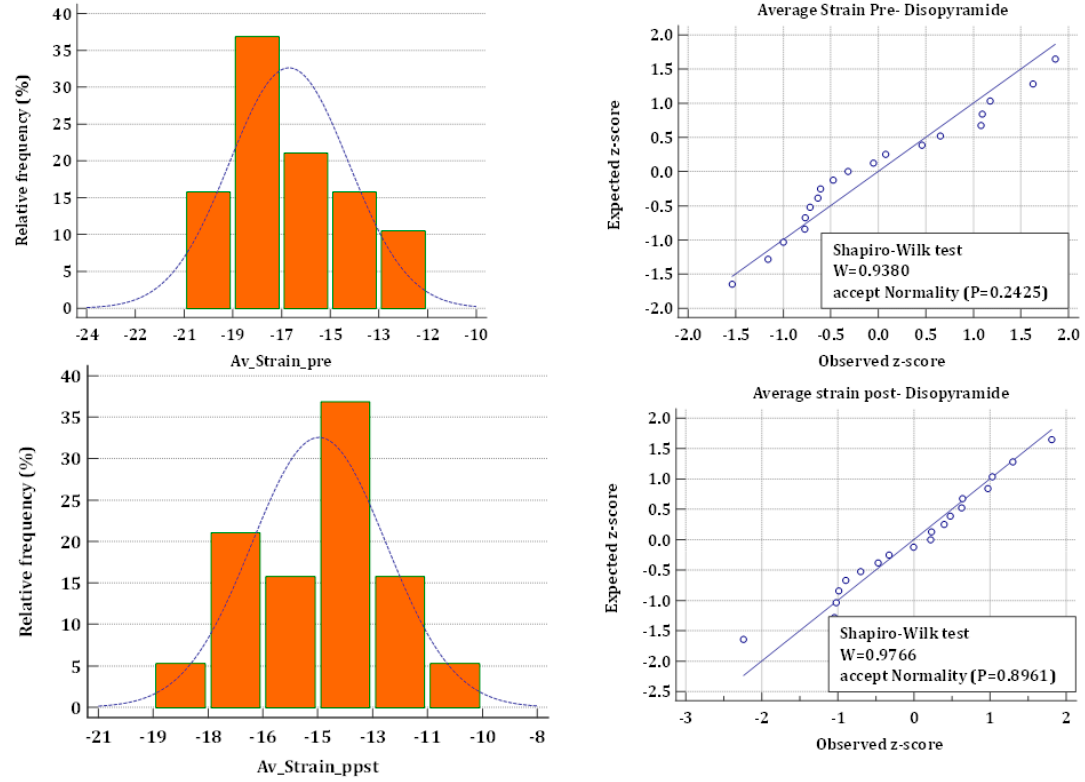
Figure 1. Shapiro-Wilk test for Normality of strain